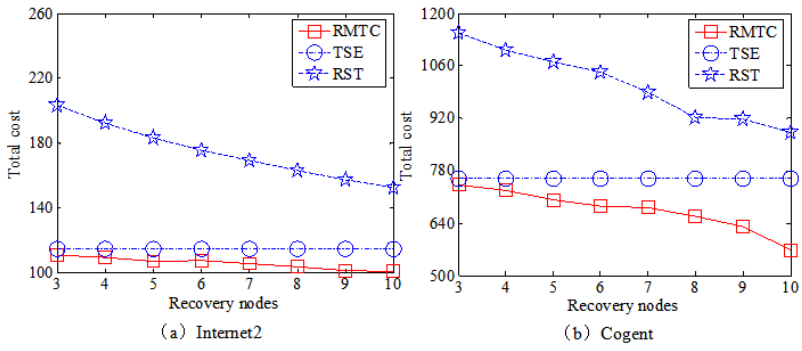
Figure 12. Impact of the number of recovery nodes in ( a ) Internet2, ( b )